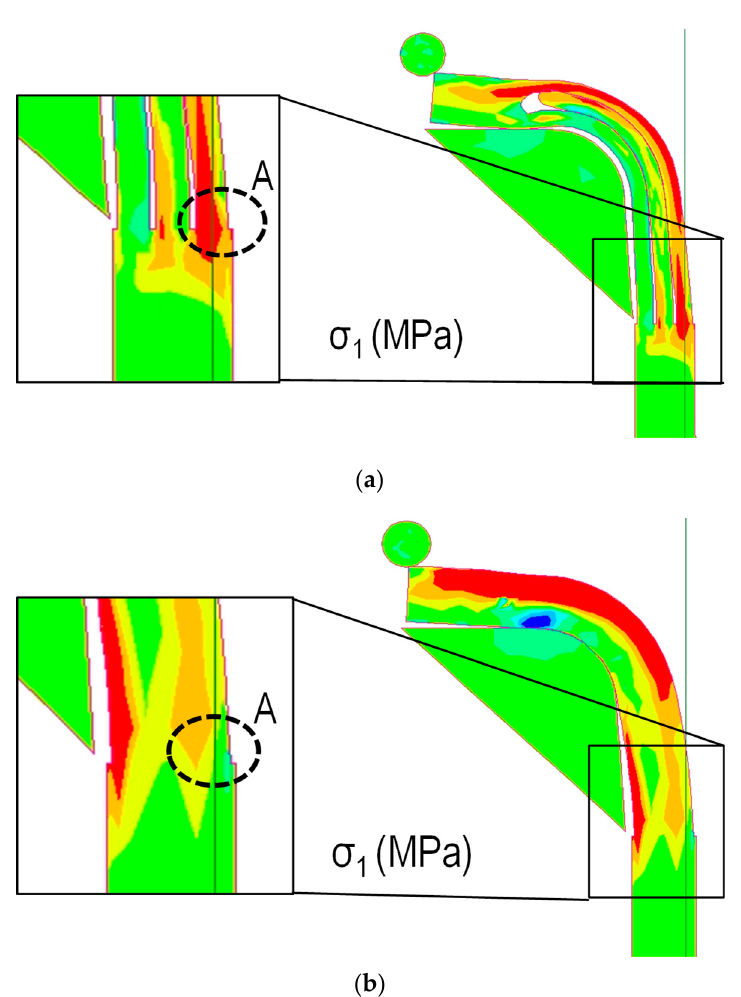
Figure 13. Maximum principal stress distribution ( σ 1 ) in the case ( a ) with gaps, and ( b ) without gaps at the interface between copper and Inconel 601.